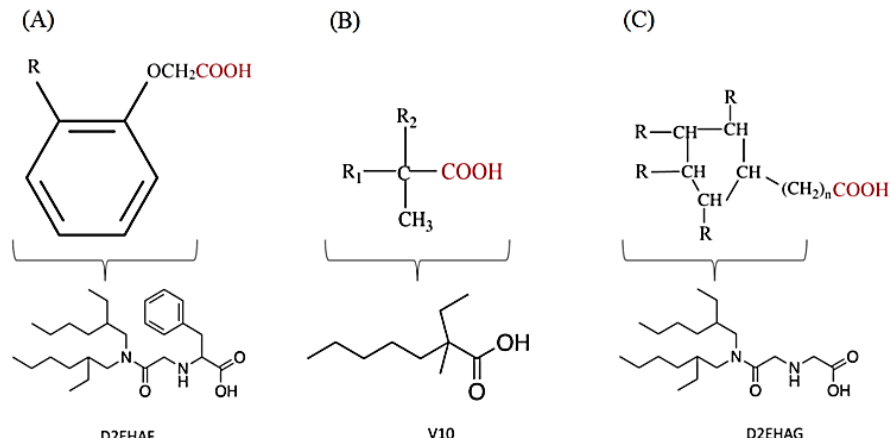
Figure 3. Chemical structure of the carboxylic acids used as typical scandium extractants: ( A )— phenoxy acetic acid, ( B )—versatic acid, and ( C )—naphthenic acid, adapted from